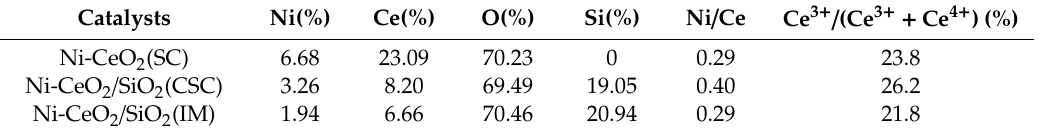
Table 3. Surface atomic ratio determined from XPS analysis for fresh catalysts.